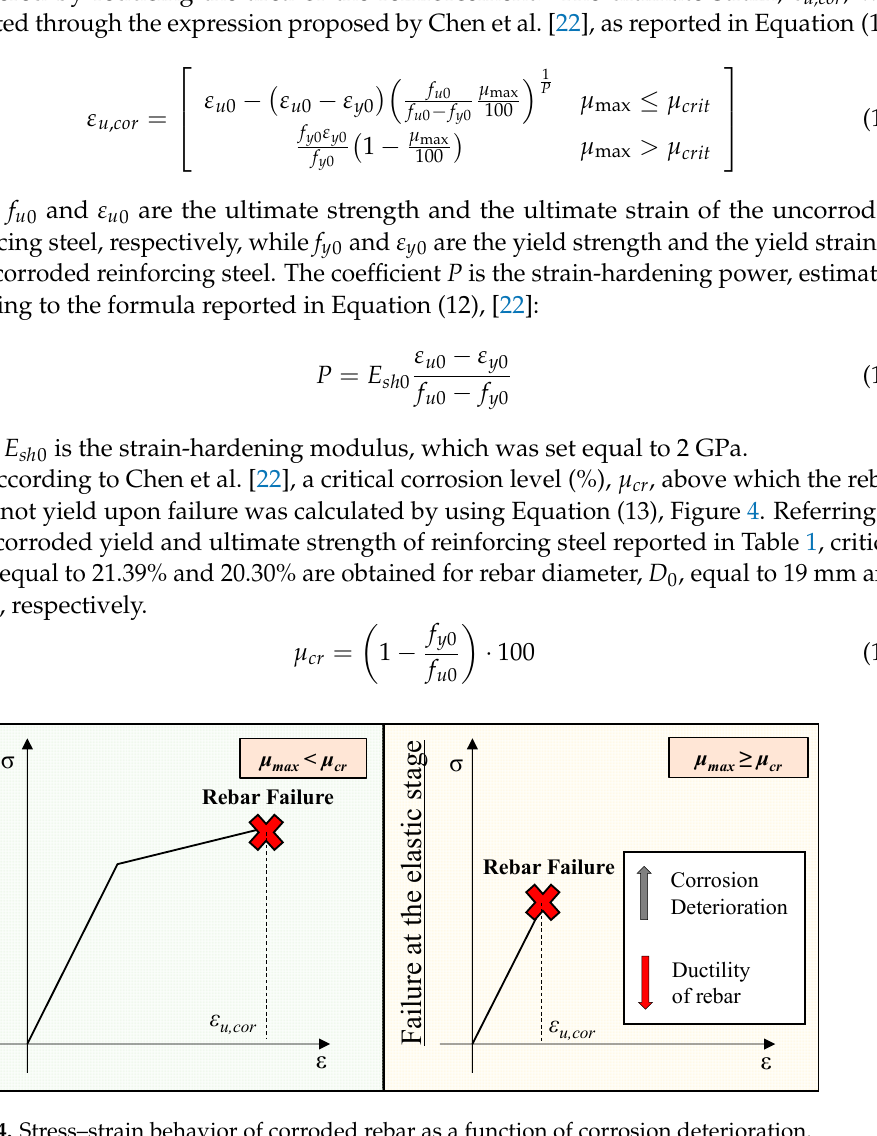
Figure 4. Stress–strain behavior of corroded rebar as a function of corrosion deterioration.